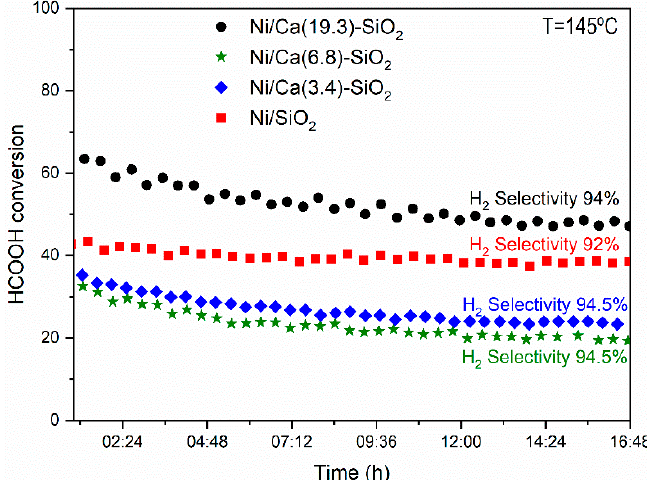
Figure 8. Stability test of the catalysts after reduction at 400 °C in the fixed-bed reactor. (Reaction temperature = 145 °C, W/F = 5 × 10 − 5 g·h·mL − 1 , feed composition: 6% HCOOH/N 2 .)